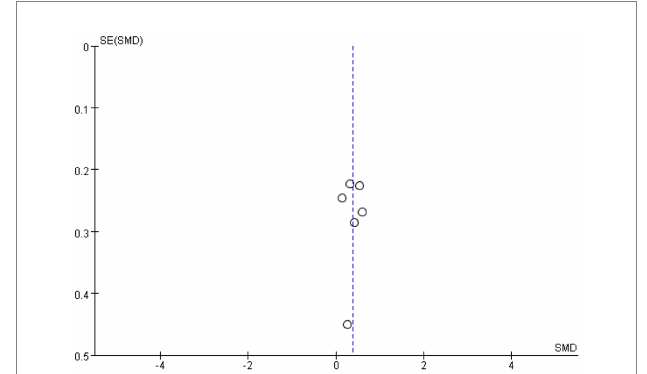
FIGURE 8 Funnel plots of upper limb.